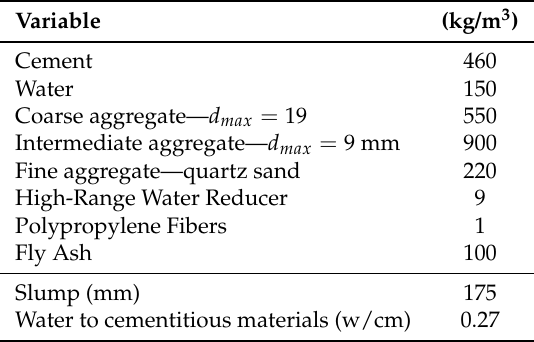
Table 2. Properties of the concrete